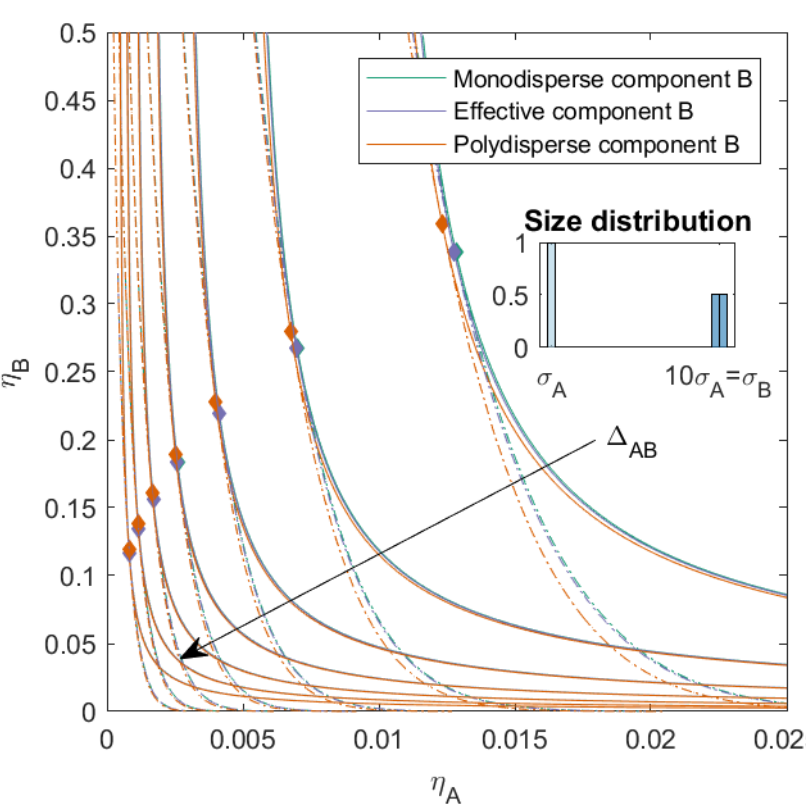
Figure 2. Phase diagram for binary (components A and B ) nonadditive hard sphere mixture with size ratio q = σ A / σ B = 1/10 plotted as a function of the partial packing fractions, η A and η B ; as indicated in the inset, component A is monodisperse, component B is polydisperse ( PD = 4.00). The symbols σ A and σ B refer to the diameters of species A and B, respectively. The interaction between components A and B is nonadditive, the nonadditivity parameter ∆ AB was varied from − 0.1 to 0.5 with a step size of 0.1 (the arrow indicates increasing ∆ AB ). The interaction between the subcomponents of B is additive. The spinodal (solid line) and binodal (dashed line) meet each other at the critical point